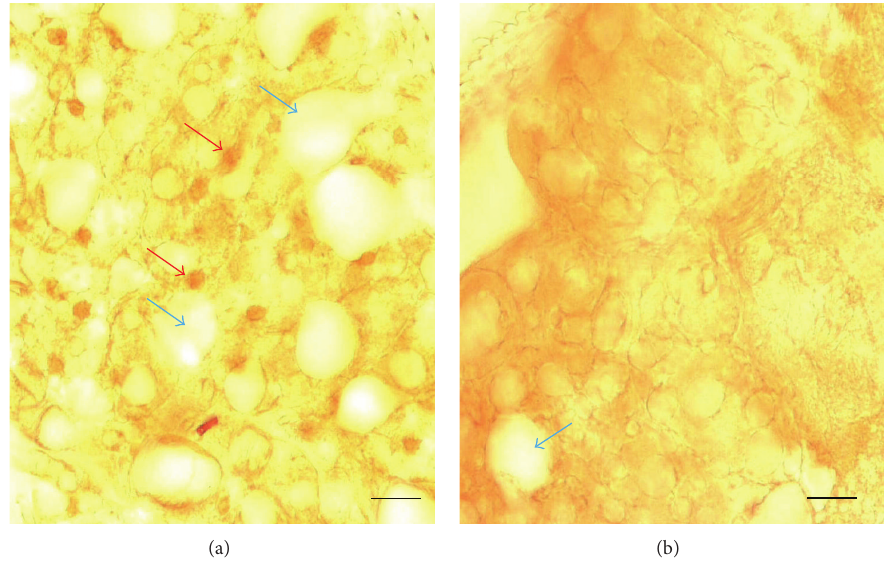
Figure 2: Effect of total Pdp1 RNAi induced in adult Drosophila on PDP1 protein immunostaining in the fat tissue. Flies were injected with control dsRNA (panel (a)) and dsRNA targeted at a sequence common to all known Pdp1 isoforms (total Pdp1 RNAi; panel (b)). They were processed for PDP1 immunolabeling five days later. Shown is a high magnification (objective 20X) of abdominal fat tissue section (size bar = 20 𝜇 m). Note the presence of strong nuclear PDP1 protein immunolabeling (dark circles indicated by red arrows) in the control section (a) and its absence in the Pdp1 RNAi section (b). Also, indicated (blue arrows) are multiple white circles of lipid droplet-containing cells in the control section and their reduced number after Pdp1 RNAi.